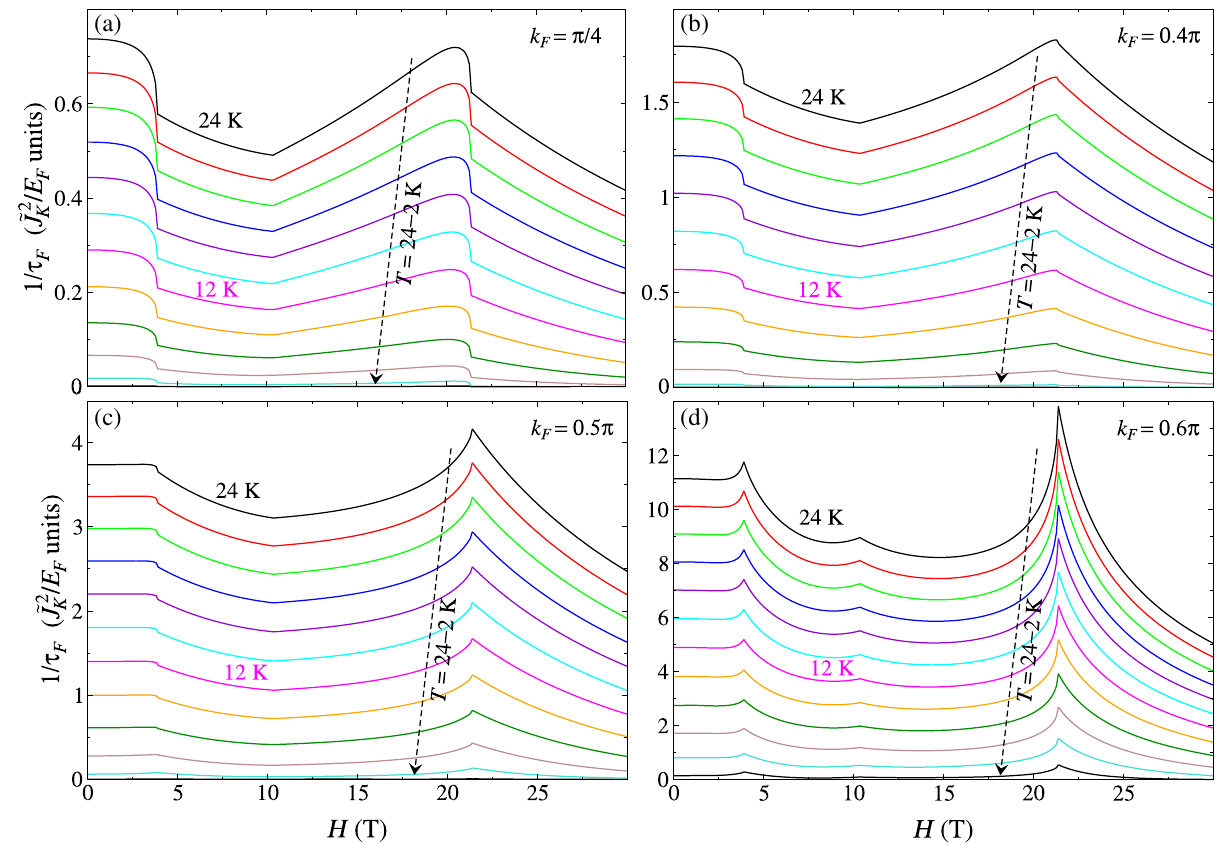
π = 4 , (b) k 0 . 4 π , (c) k 0 . 5 π , and (d) k F ¼ F ¼ F ¼